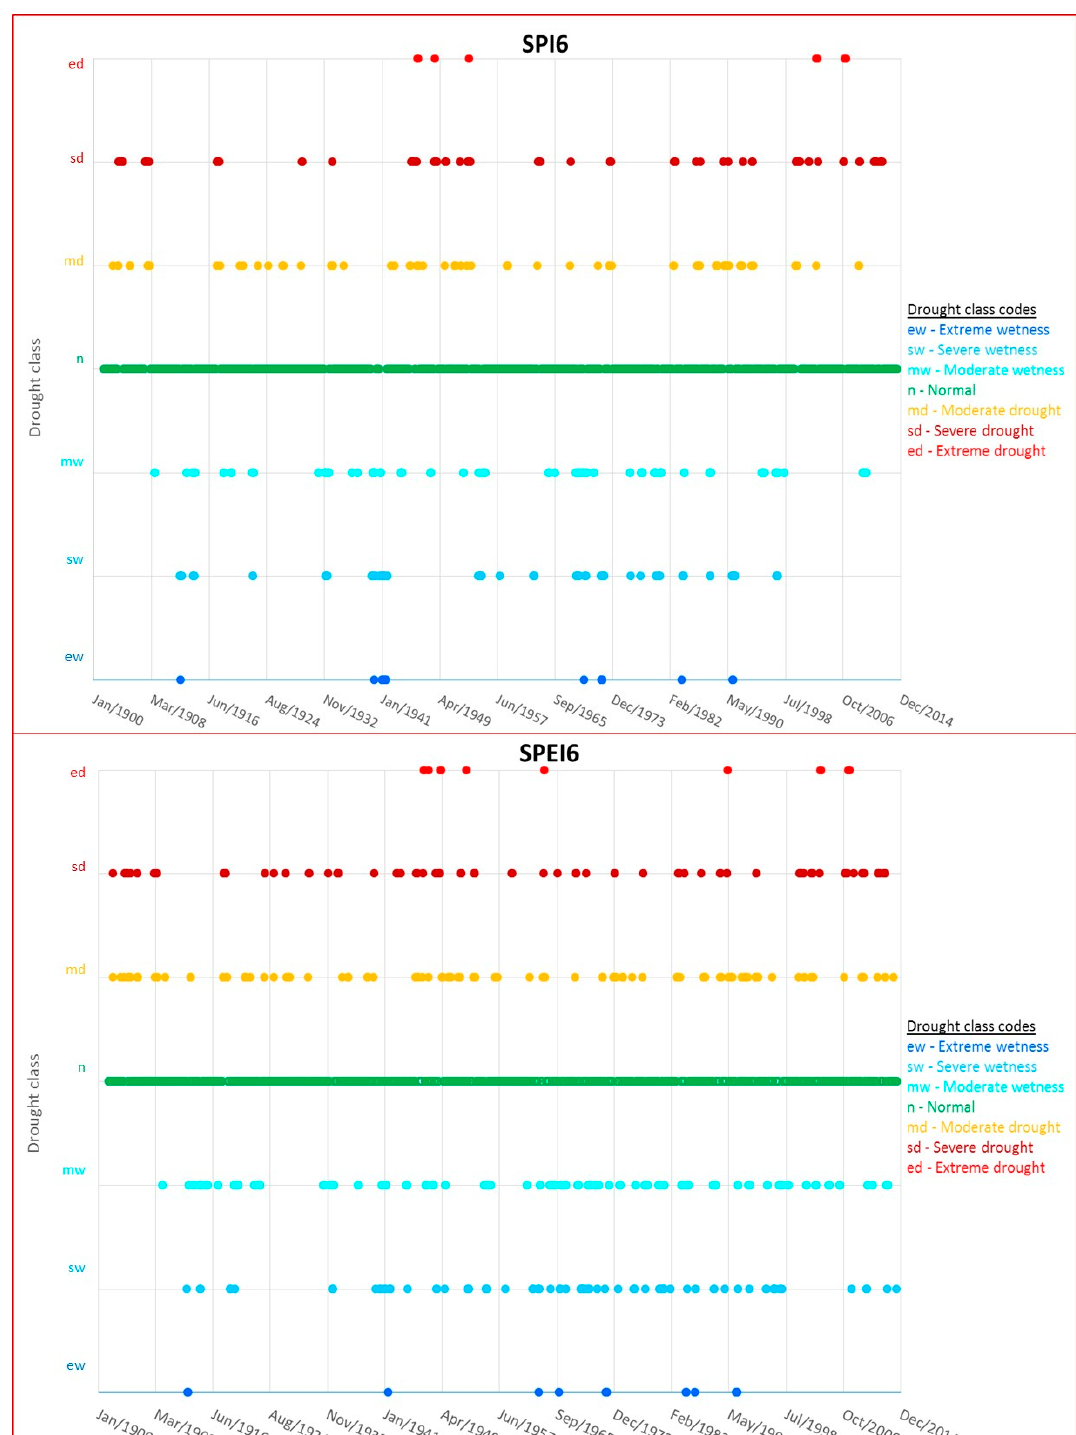
Figure 2. Most frequent classes by month for SPI6 and SPEI6.